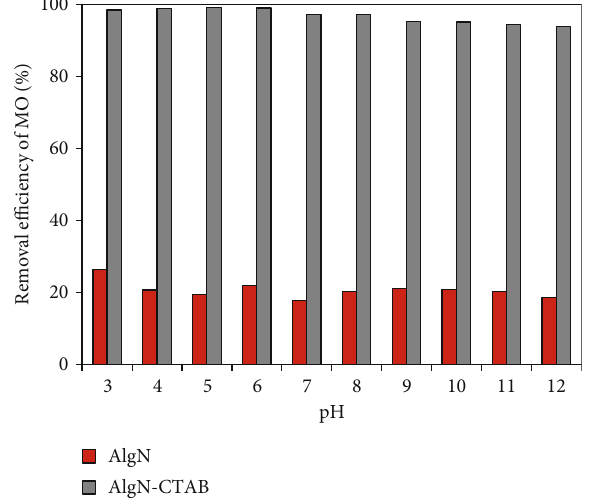
Figure 5: Impact of pH on the removal of MO dye using AlgN and AlgN-CTAB ( adsorbent mass = 0 : 1g , ½ MO (cid:2) interaction time = 60 min , and T = 27 ° C ).